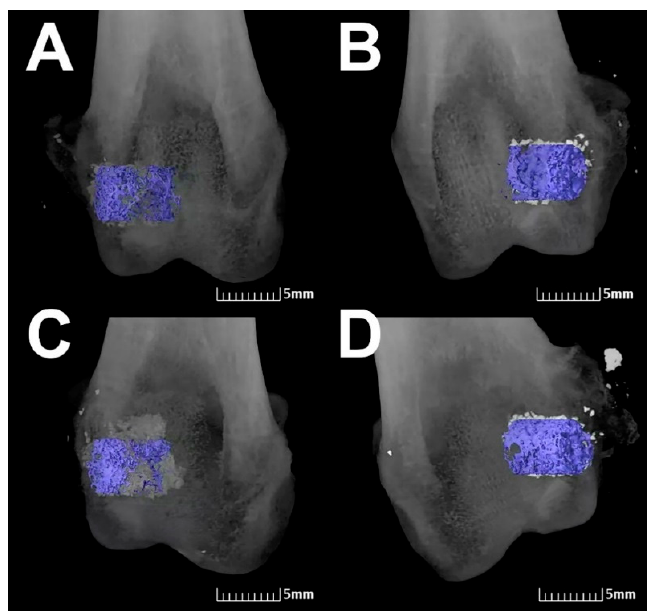
Figure 3. Representative MicroCT images at 8 weeks post-implantation of autologous bone marrow aspirate with non-porous ( A ) or porous ( B ) HA microparticles. Similar images taken at 13 weeks post-implantation for non-porous ( C ) and porous ( D ) HA microparticles. New bone formation (purple) and residual scaffold material (white, light gray) were calculated as a total volume and percentage of the original defect volume.